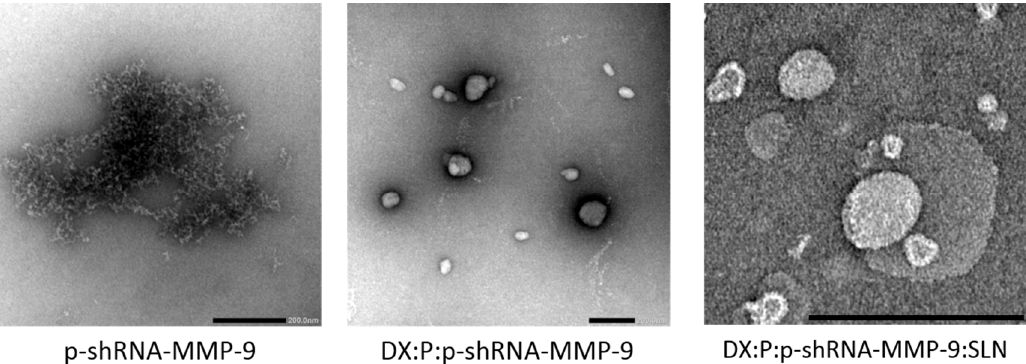
Figure 1. The images of p-shRNA-MMP-9, DX:P:p-shRNA-MMP-9 complex ( w / w ratio 2:1:1), and